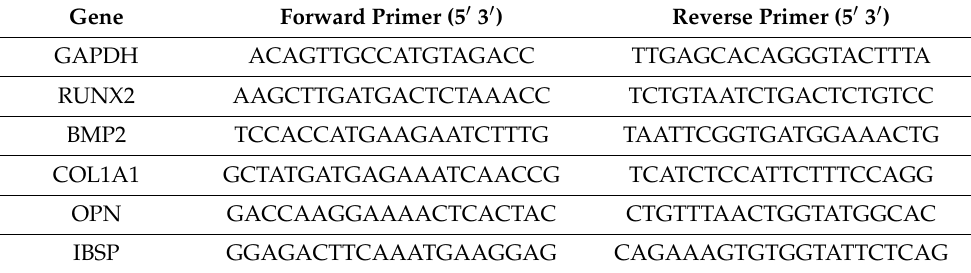
Table 2. Forward and reverse primer sequences for